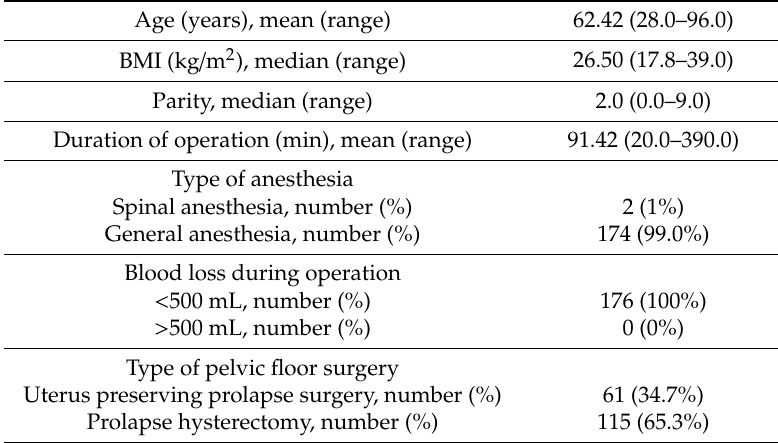
Table 1. Patients’ characteristics of 176 included